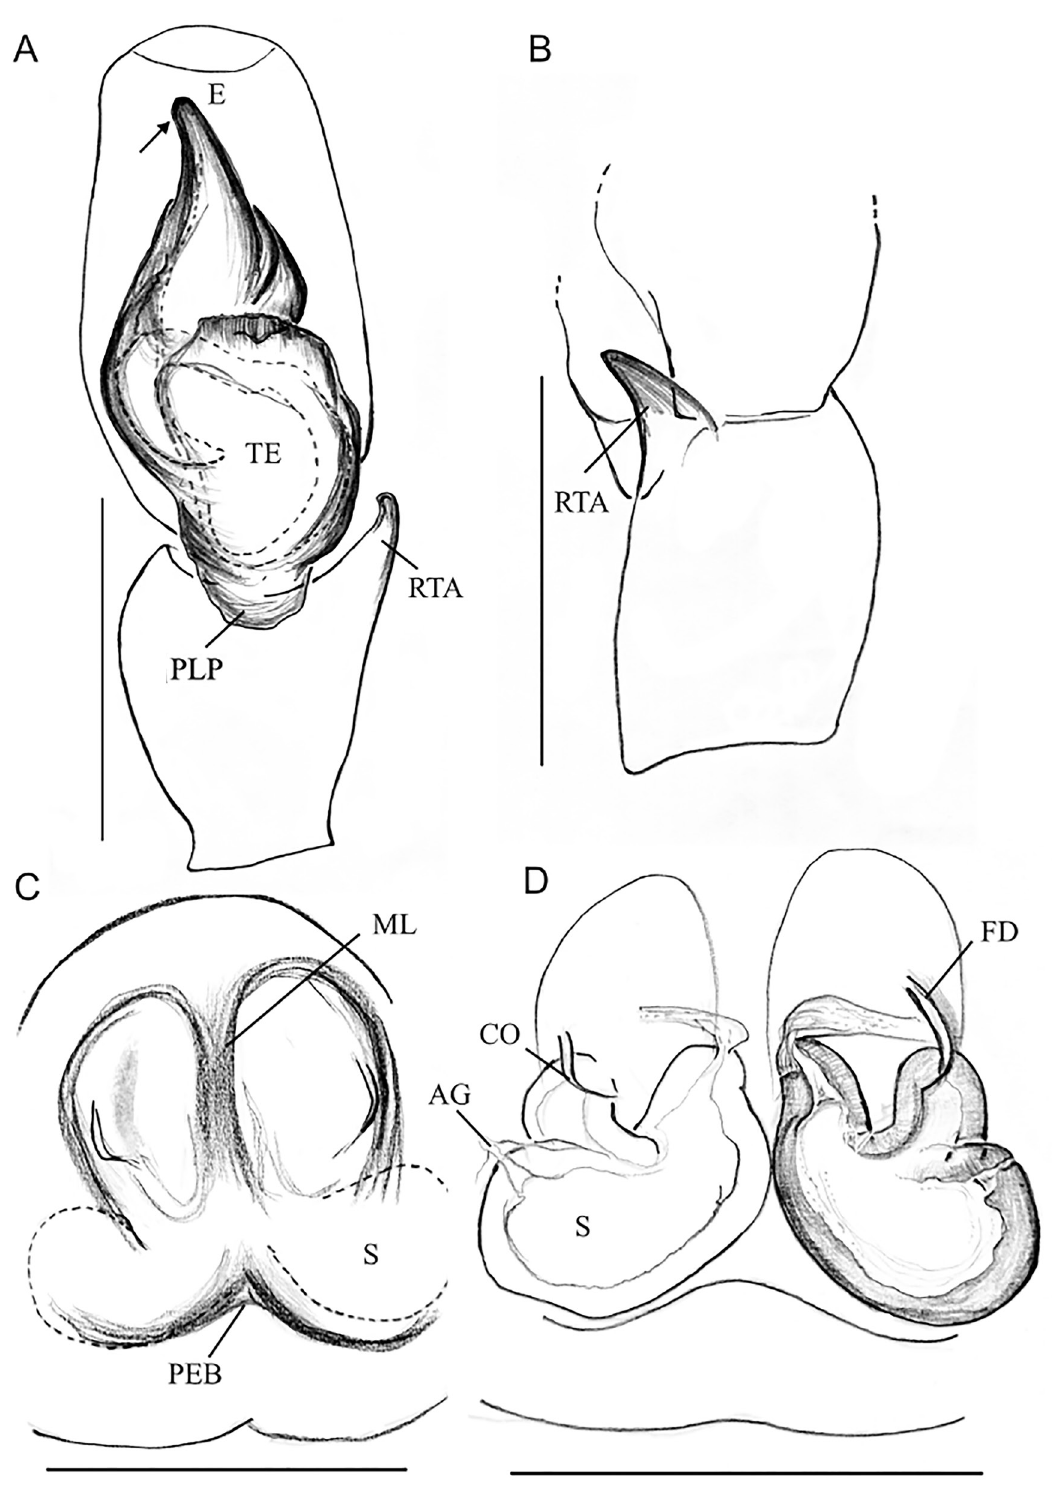
Fig 16. Carrhotus viduus (C.L. Koch, 1846). A–B . Palp. A . Ventral view. B . Retrolateral view. C–D . Epigynum. C . Ventral view. D . Dorsal view. Abbreviations: AG = accessory gland; CO = copulatory opening; E = embolus; FD = fertilization duct; ML = mid line; PEB = posterior epigynal border; RTA = retrolateral tibial apophysis; S = spermatheca; TE = tegulum. Scale bars: A–B = 0.2 mm; C–D = 0.1